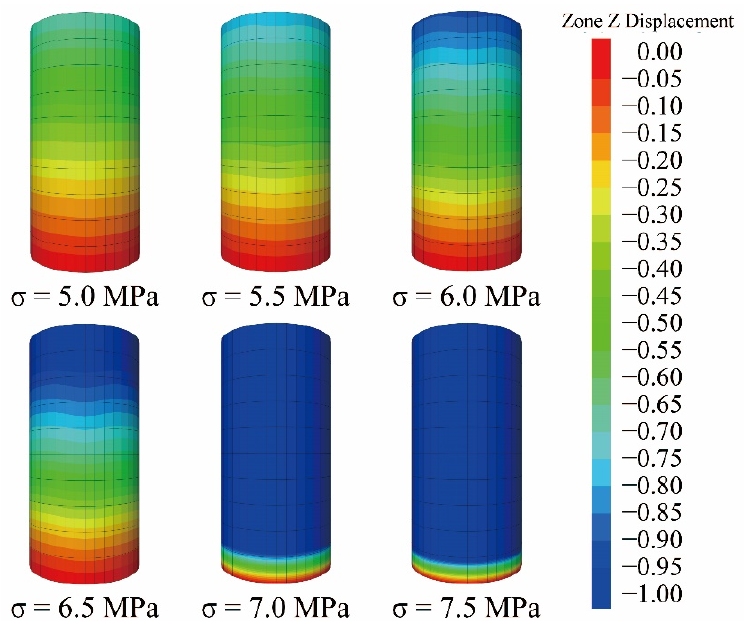
Figure 17. Creep displacement cloud diagram of the whole simulation process.